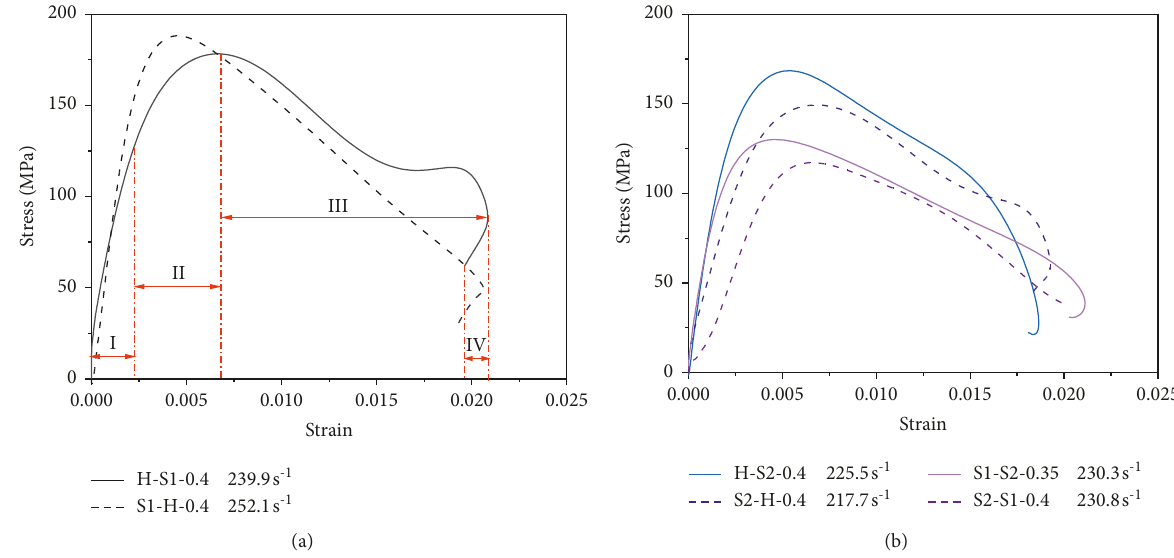
Figure 6: Typical dynamic stress-strain curves of composite specimens. (a) H-S1, (b) H-S2, and S1-S2 with similar strain rates.